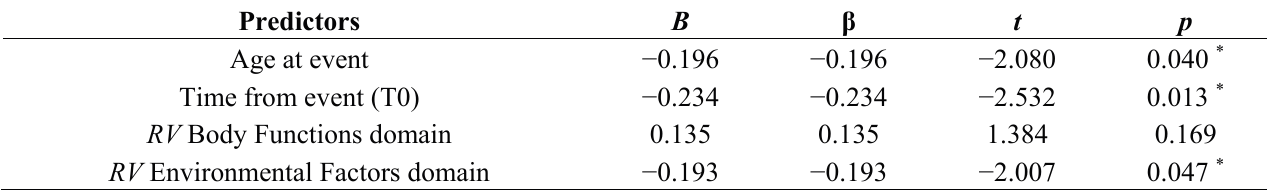
Table 7. Predictors of relative variability in Activities & Participation